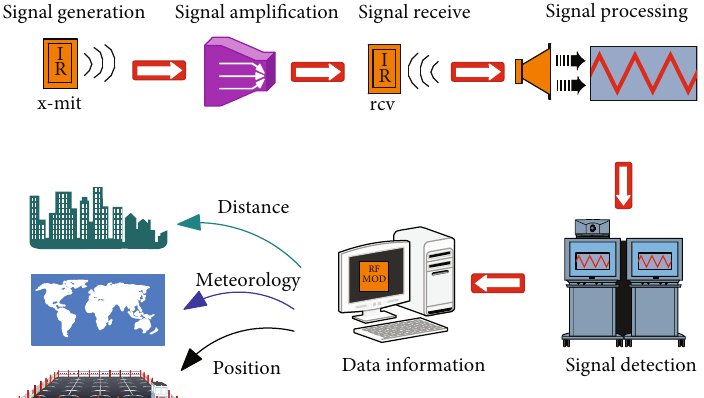
Figure 1: Article structure